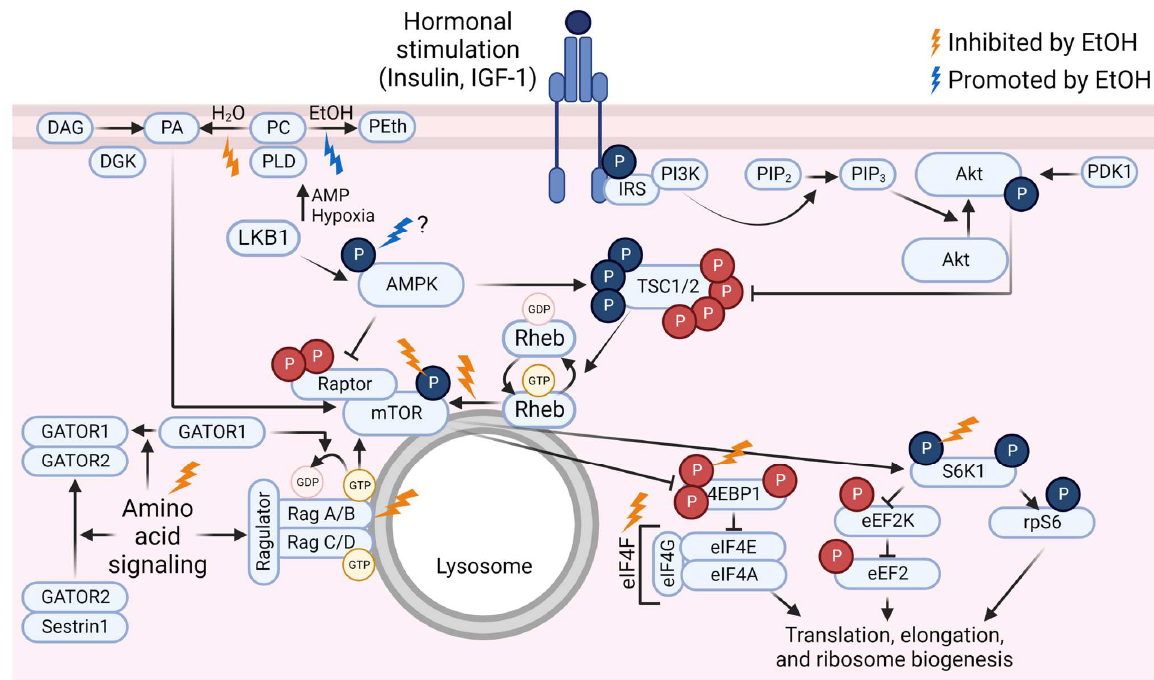
Figure 1. Overview of the mammalian/mechanistic target of rapamycin (mTOR) signaling pathway and events that are inhibited (gold lightning bolts) or promoted (blue lightning bolt) by ethanol (EtOH). Phosphate groups (P) in red indicate inhibitory events; P in blue indicate activating events. Abbreviations: 4E binding protein 1 (4EBP1), AMP-activated protein kinase (AMPK), diacylglycerol